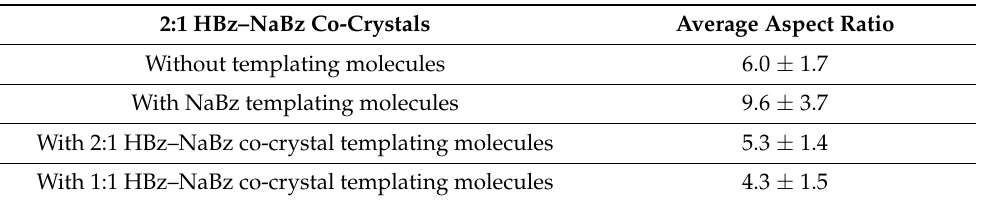
Table 4. Average aspect ratios of the 2:1 HBz–NaBz co-crystals generated with and without templating molecules at S 0 = 1.66.